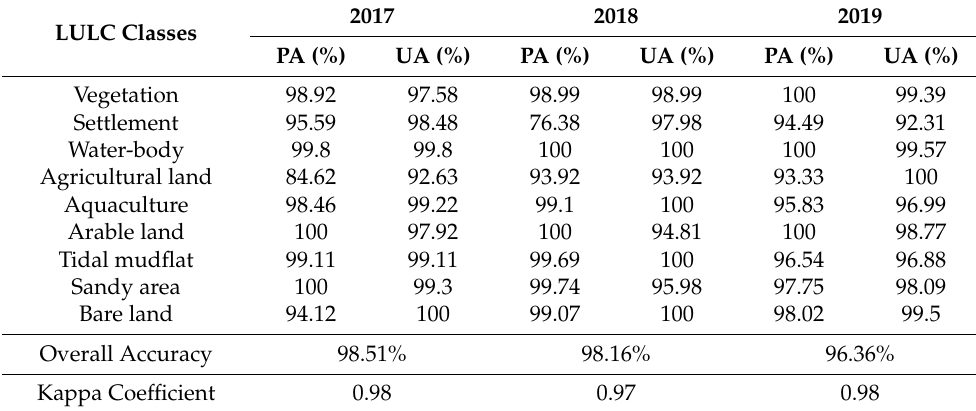
Table 3. Image classification accuracy verification values of 2017, 2018, and 2019 (here, PA = Pro- ducer’s accuracy and UA = User’s